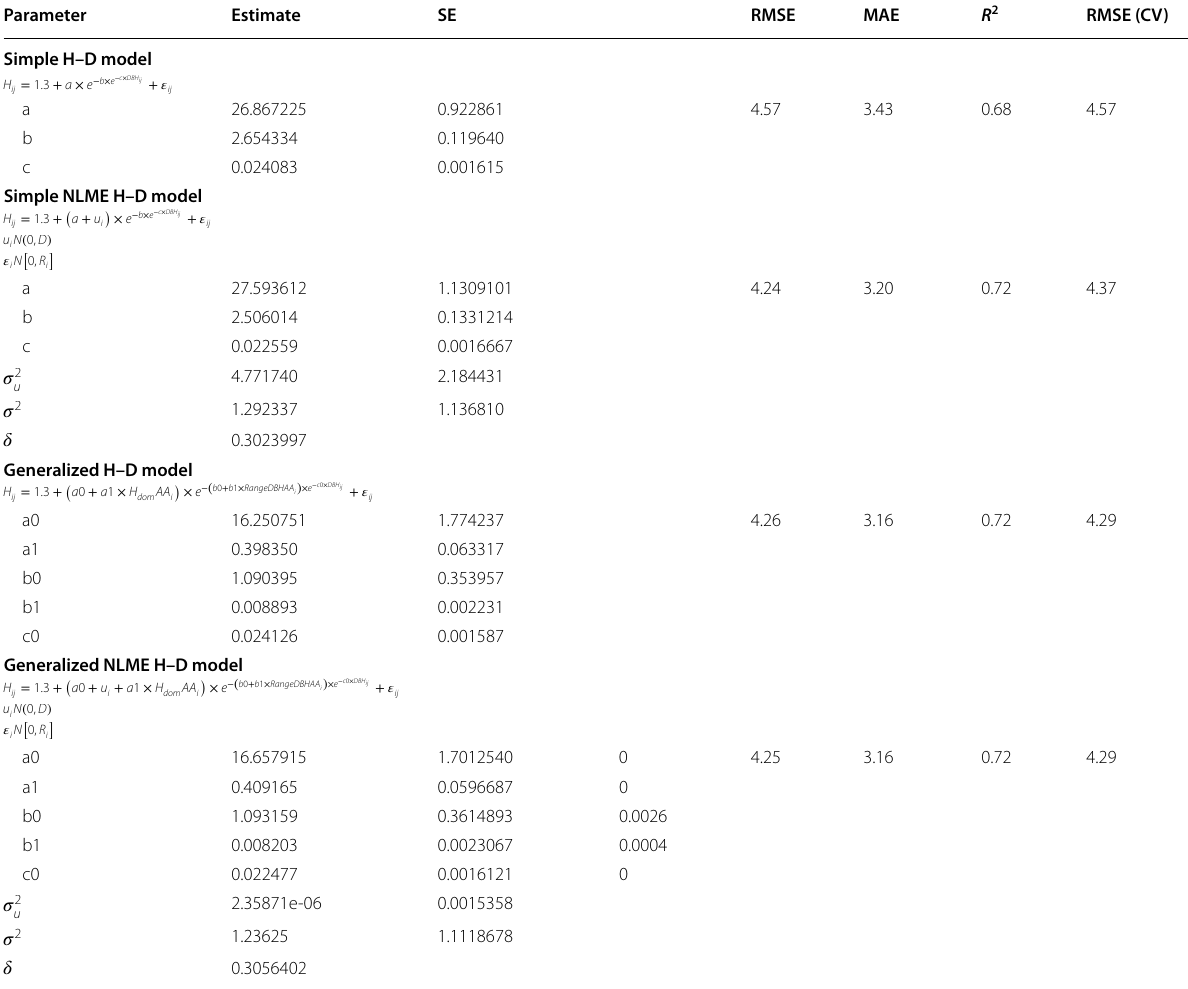
Table 15 Estimated parameters and goodness of fit of the H–D models for A. araucana fitted to the complete database Parameter